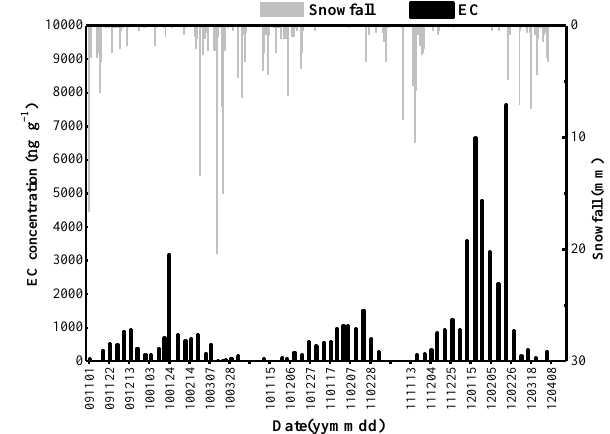
Fig. 2. EC concentrations in surface snow (ng g −1 , weekly sampling) and daily 681 snowfall in mm water equivalent for winter season 2009–2011.